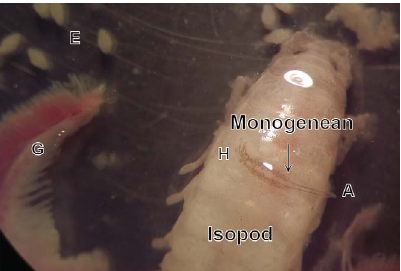
Figure 1. Photograph of Cyclocotyla bellones , on an isopod, Ceratothoa parallela , from the buccal cavity of the bogue Boops boops . E, egg. G, gill. H, haptor of the monogenean. A, anterior stem of the